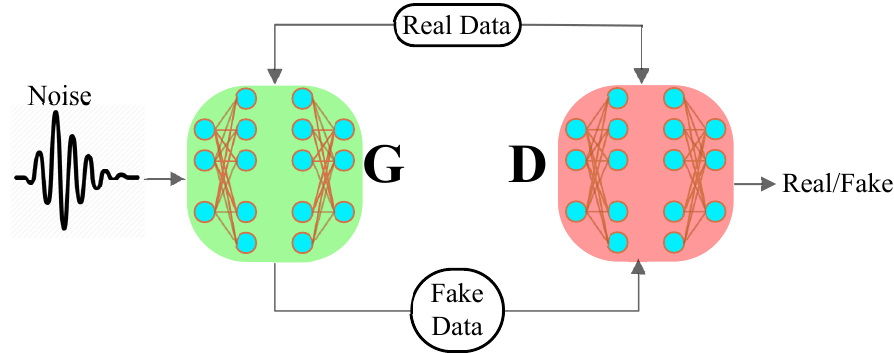
Figure 2. The general structure of GAN proposed by